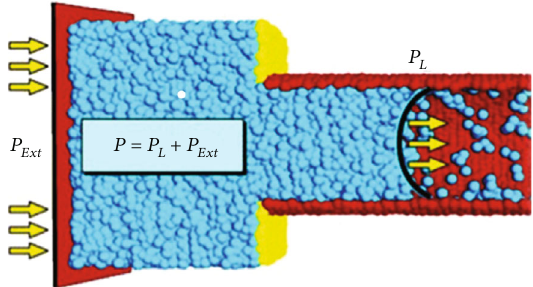
Figure 1: Schematic diagram of high-pressure imbibition